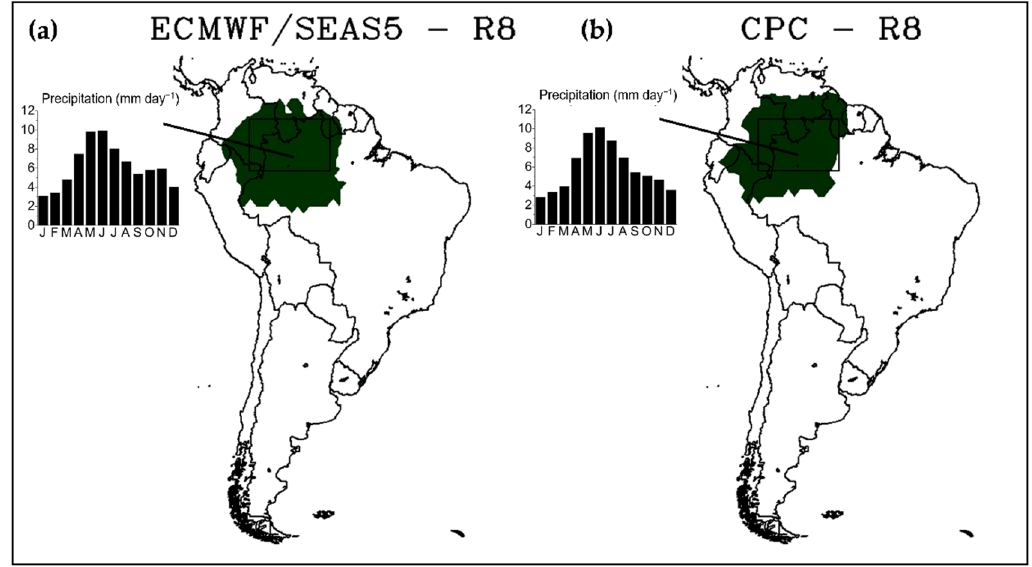
Figure 13. Similar to Figure 6, except for Region 8